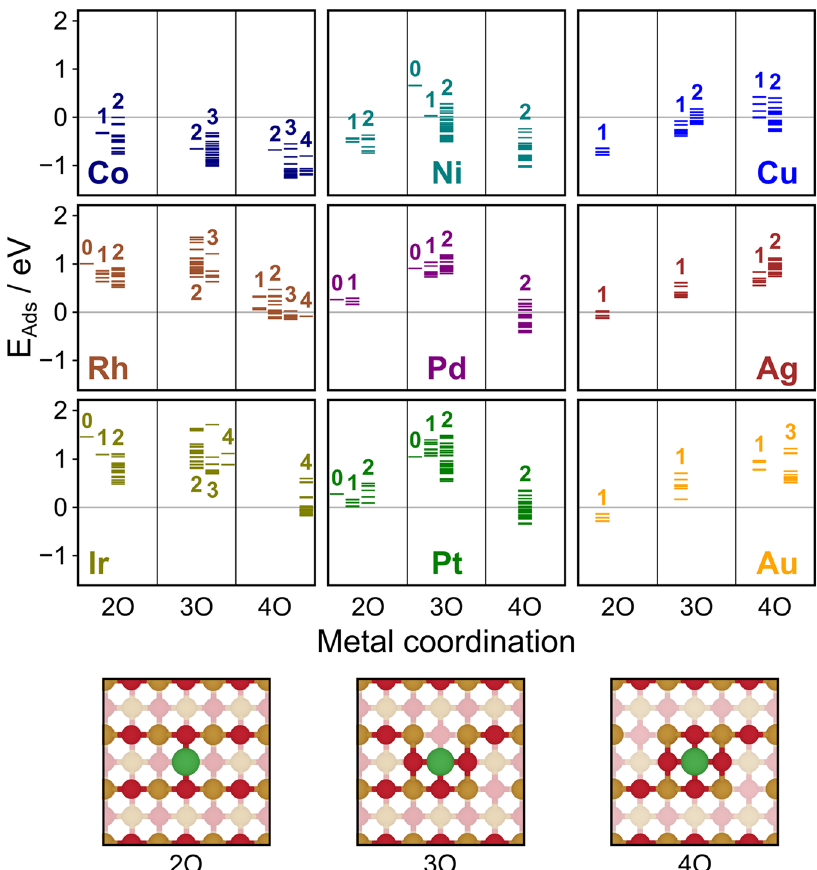
Fig. 2 Adsorption energies for ground and accessible excited states of the investigated CeO 2 (100)-based transition metal (TM) SACs. The individual values were obtained via: E Ads = E total − E 2Osurface − E bulk metal . Each TM is represented by one panel. The different coordination environments (illustrated in the bottom row) are separated horizontally within each panel. Metal oxidation states, mOS, are annotated above/ below the respective energy